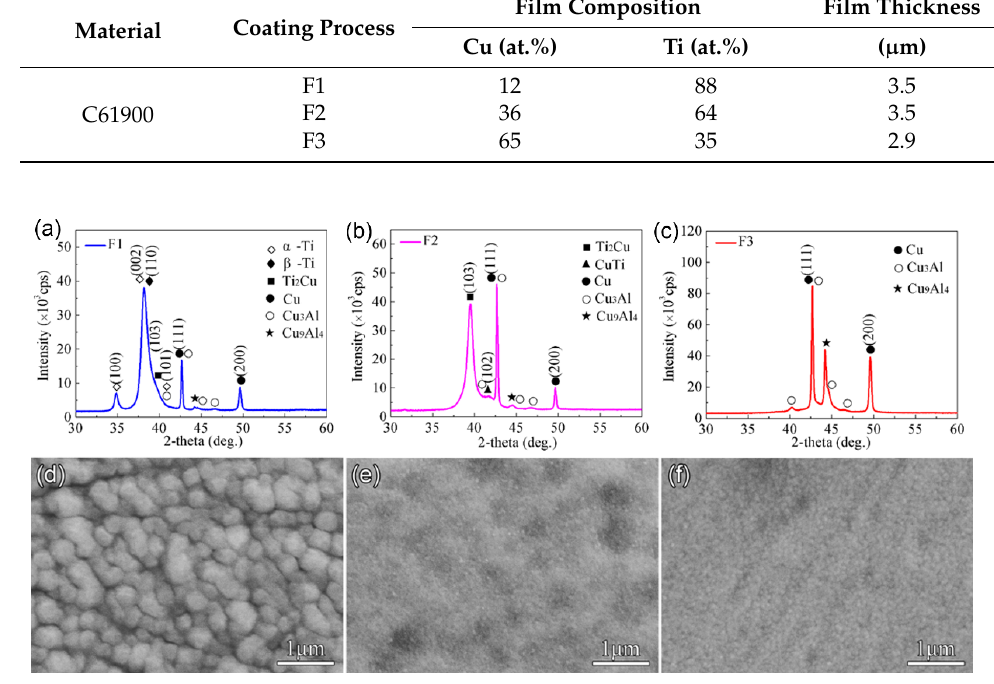
Figure 1. XRD results and SEM images of the Cu-Ti films on C61900 Cu alloy: ( a , d ) for F1, ( b , e ) for F2, ( c , f ) for F3.